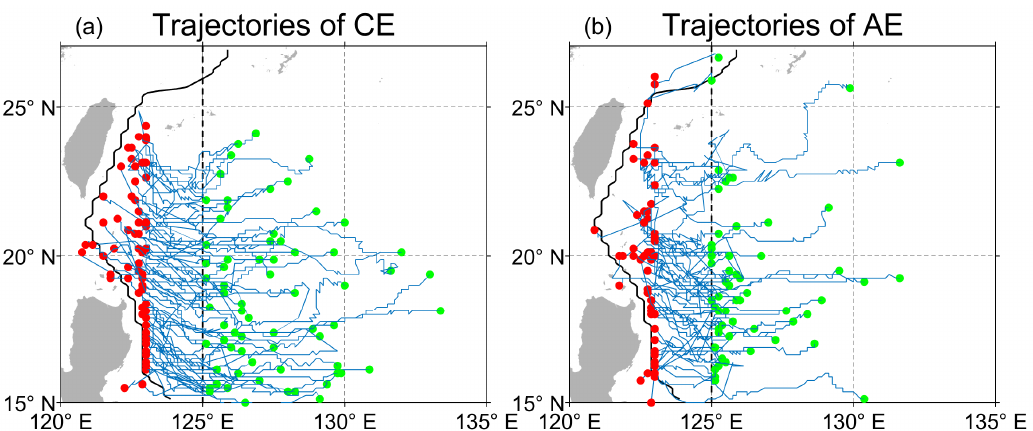
Figure 2. Trajectories of the detected ( a ) cyclonic and ( b ) anticyclonic eddies. The solid black line represents the maximum velocity axis of the surface of the Kuroshio, with the velocity fields obtained by averaging the AVISO sea surface geostrophic velocity from 1993 to 2017. The dashed black line is the starting position of the eddy–the Kuroshio interaction. Green (red) dots represent the locations of eddy generation (termination).